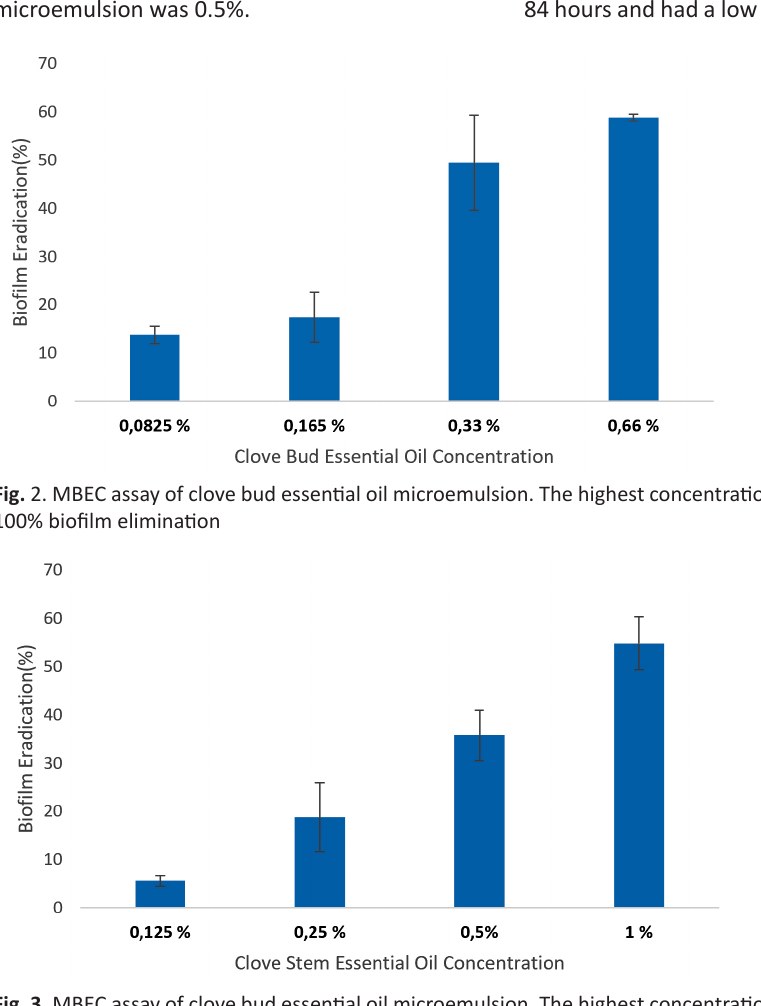
Fig. 3. MBEC assay of clove bud essential oil microemulsion. The highest concentration evaluated did not result in 100% biofilm